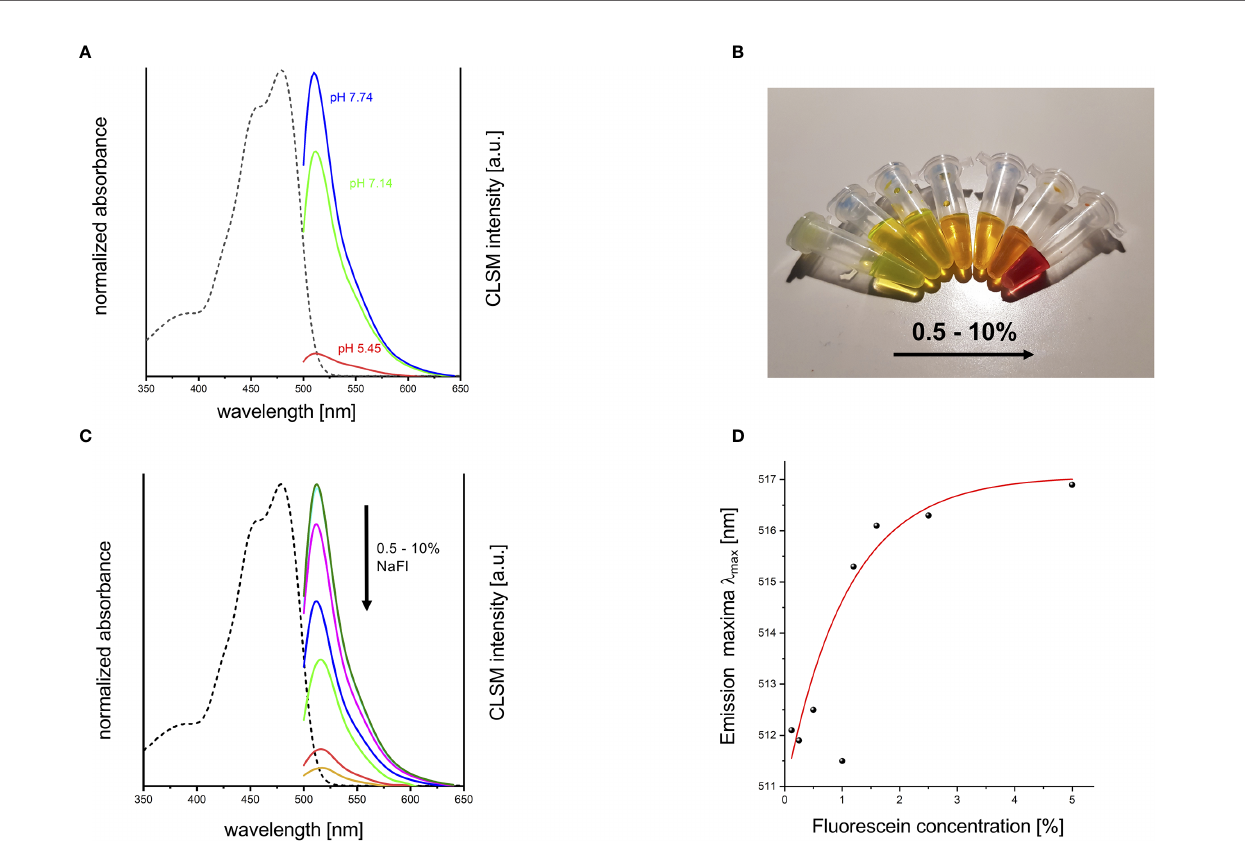
FIGURE 4 | pH- and concentration-dependent emission of NaFl. (A) Normalized absorbance (in 0.9% NaCl solution; dashed line) and pH dependent emission spectra of NaFl solutions in different phosphate buffers (phosphate buffer pH 5.54, pH 7.35, and pH 8.04) obtained with a confocal laser scanning microscope (CLSM). (B) Concentration series of Na-Fl solutions (in 0.9% NaCl), and (C) the corresponding absorbance (in 0.9% NaCl solution; dashed line), and concentration-dependent CLSM emission spectra (solid lines). (D) Emission maxima l max [nm] plotted against NaFl concentration [%] show a concentration-dependent red shift by about 5